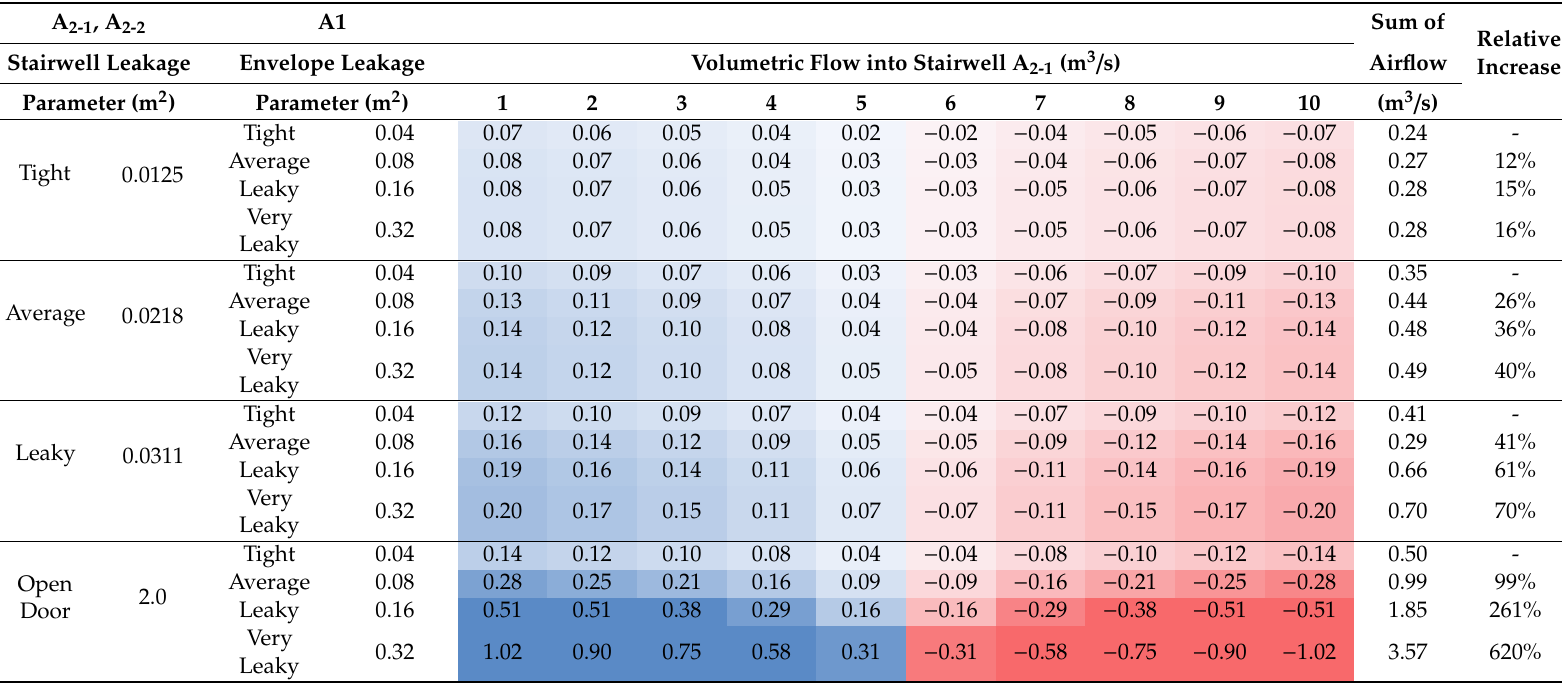
Table 4. Volumetric airflow into stairwells for variations in building envelope and stairwell